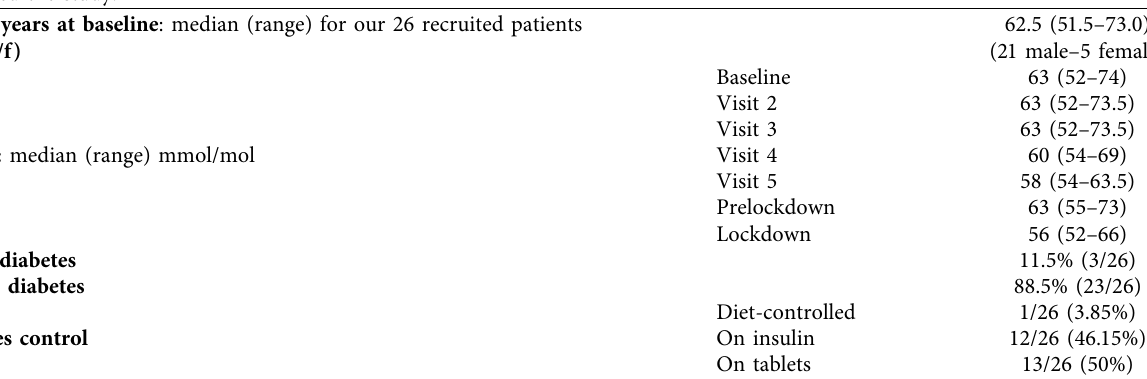
Table 1: The age, sex distribution, HbA1c levels at each visit, type of diabetes, and diabetes control measures for our 26 patients of which 24 completed the study. Age in years at baseline : median (range) for our 26 recruited